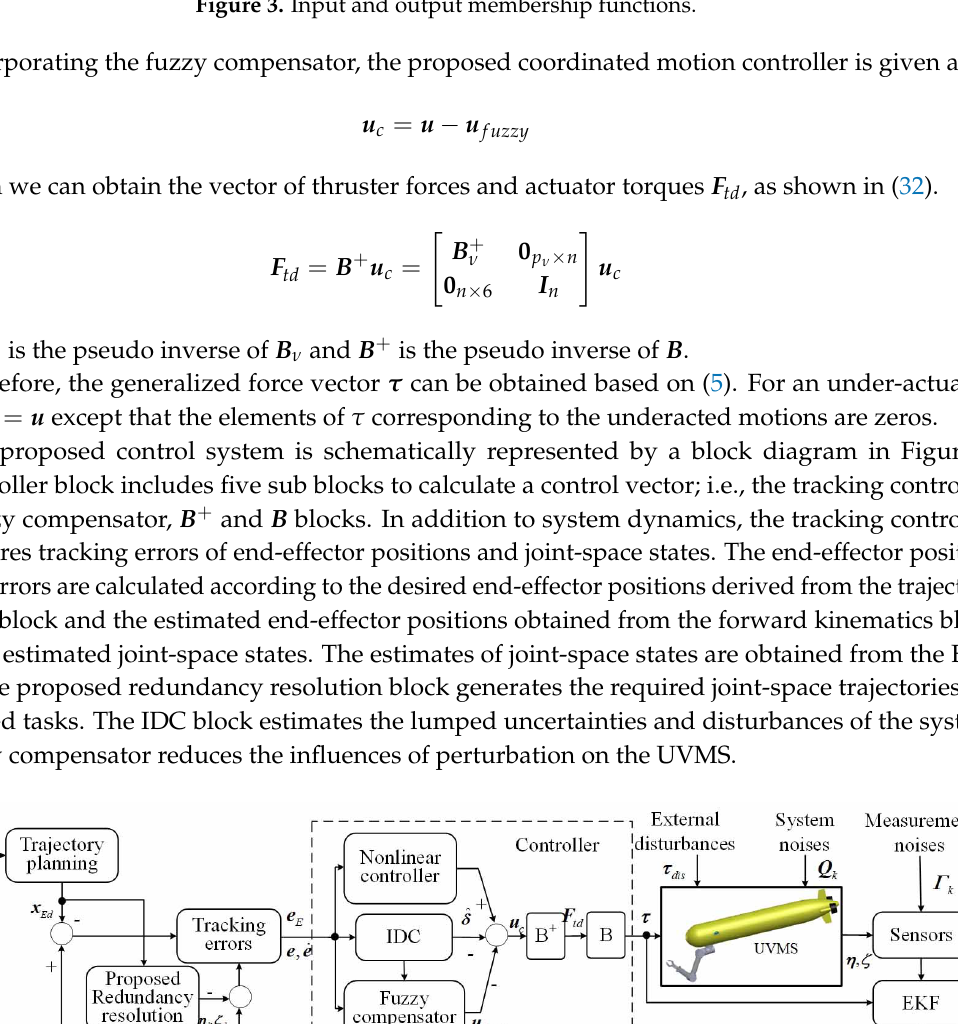
Figure 3. Input and output membership functions.